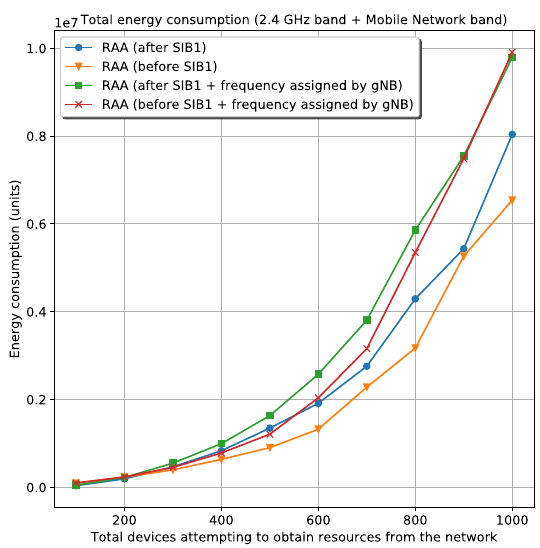
Figure 3. Total energy spent by all the devices attempting to obtain resources from the network in Wi-Fi using the 28-bit clock frequency generator.